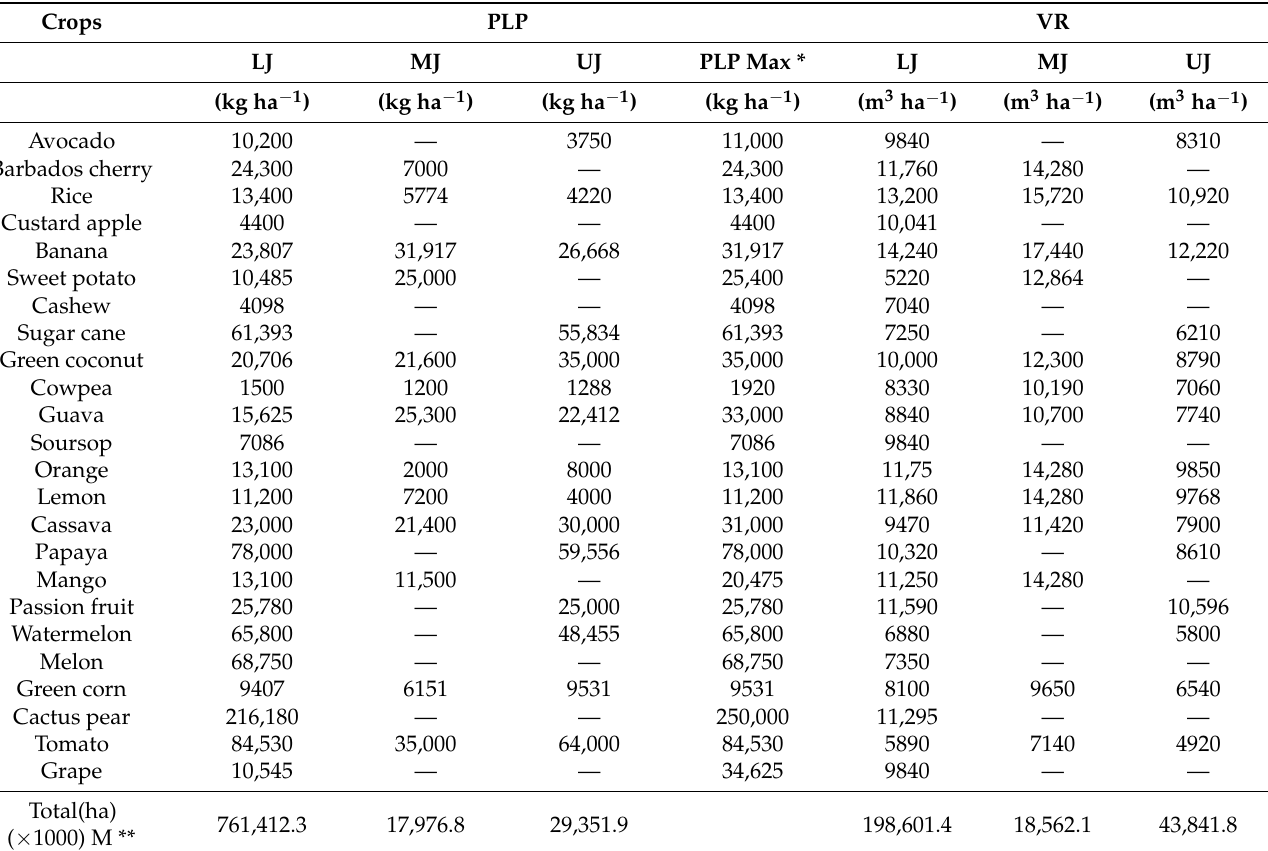
Table 2. Actual (PLP) and maximum (PLPmax) physical land productivity, and estimated net need for irrigation